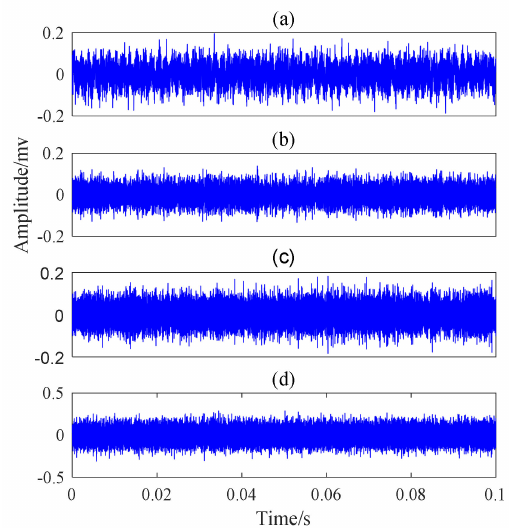
Figure 16. The IMFs of the simulation signal of the bearing with the inner race fault processed by the Improved EWT method: ( a ) IMF1; ( b ) IMF2; ( c ) IMF3; ( d ) IMF4.